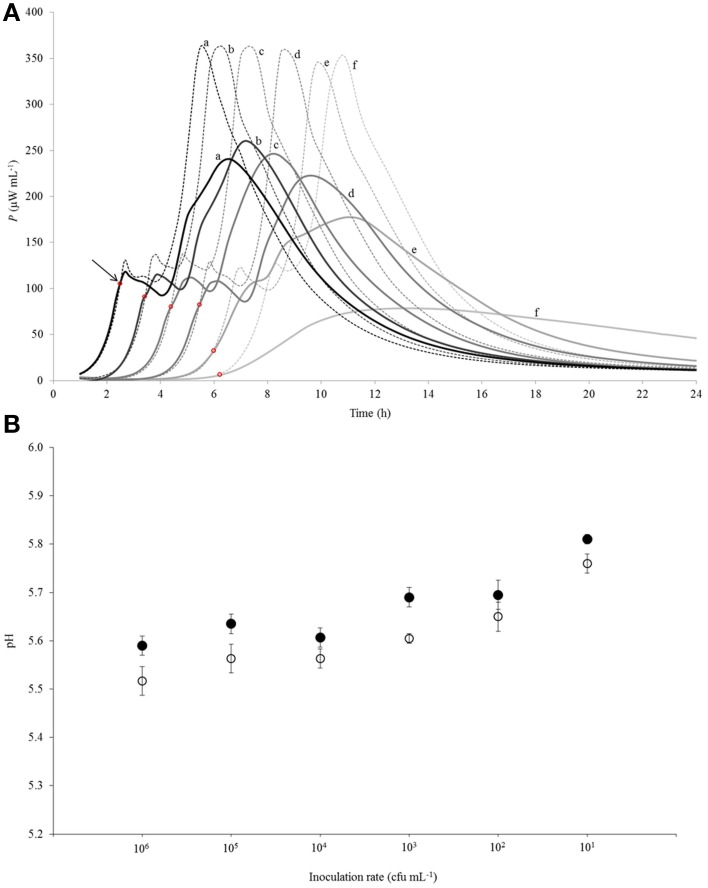
(A) Calorimetric power-time curves describing growth of Streptococcus thermophilus ST12 in liquid (dashed line) and renneted (bold line) reconstituted skim milk at different inoculation rates (CFU mL−1): (a) 106; (b) 105; (c) 104; (d) 103; (e) 102; (f) 101. The arrow and the red circles mark the “deviation moments.” (B) pH at the end of fermentation (at 22 h) at all inoculation rates (106–101 CFU mL−1) in RSM (white circles) and in r-RSM (black circles). Initial pH = 6.47 was the same in the samples.